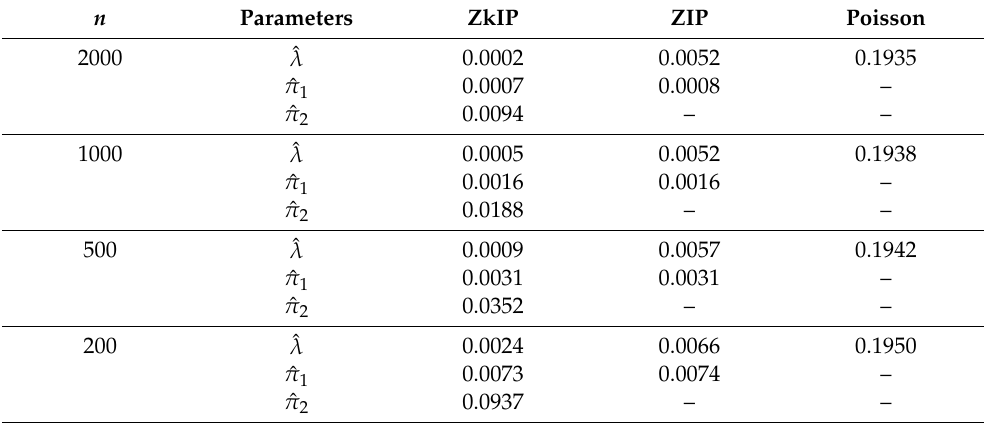
Table 8. Comparison of standardized MSE (SMSE) of the simulated data. True values λ = 5, π 1 = 0.4, π 2 = 0.1, and k = 3.